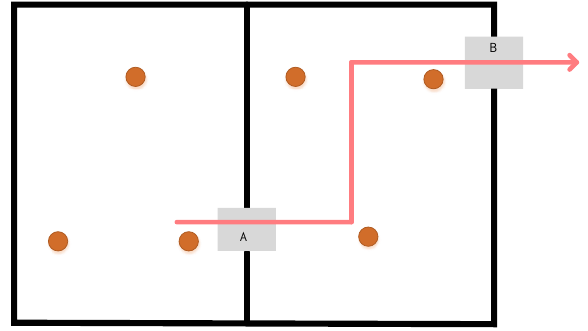
Figure 8. The connection of subspace